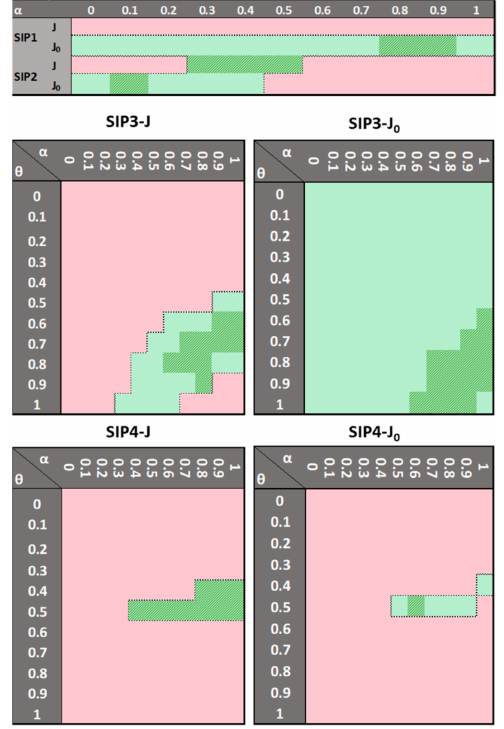
Figure 8. Convergence (green) and failure areas (red) in the s-parameter space for solving the case3375wp. Bold green areas indicate where the studied technique successfully converged, employ- ing the least number of